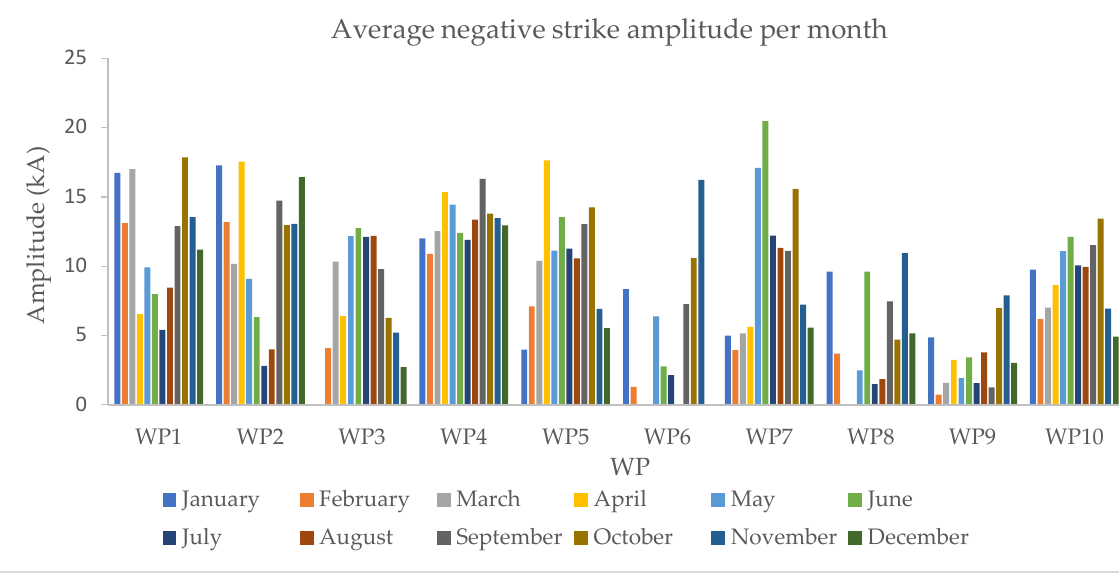
Figure 5. Monthly average amplitude (kA) of the recorded negative strikes of each wind park (observation period 2011–2020).